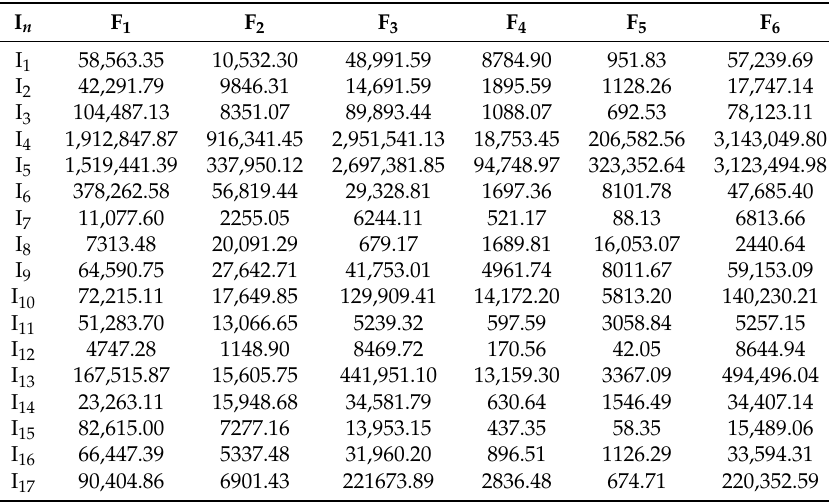
Table 11. Forecast data in 2020.